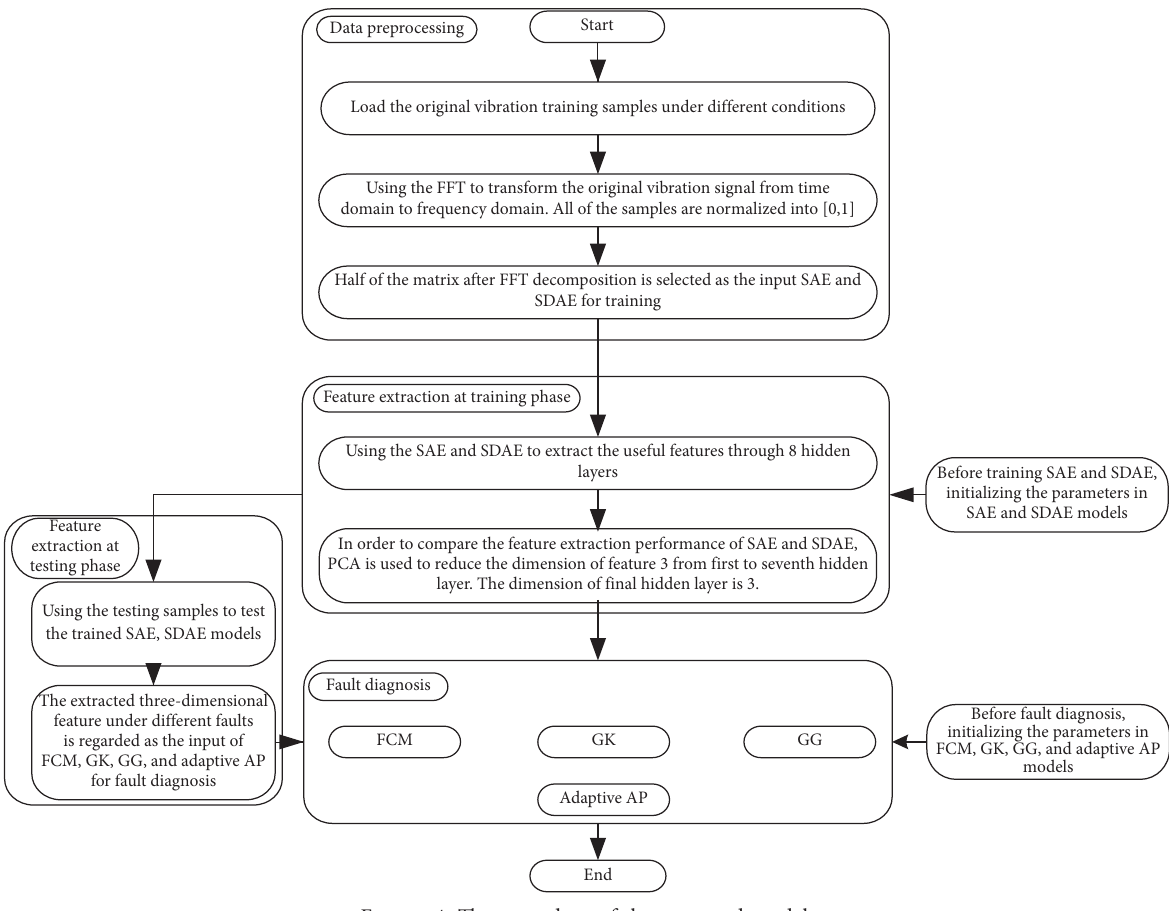
Figure 4: The procedure of the proposed